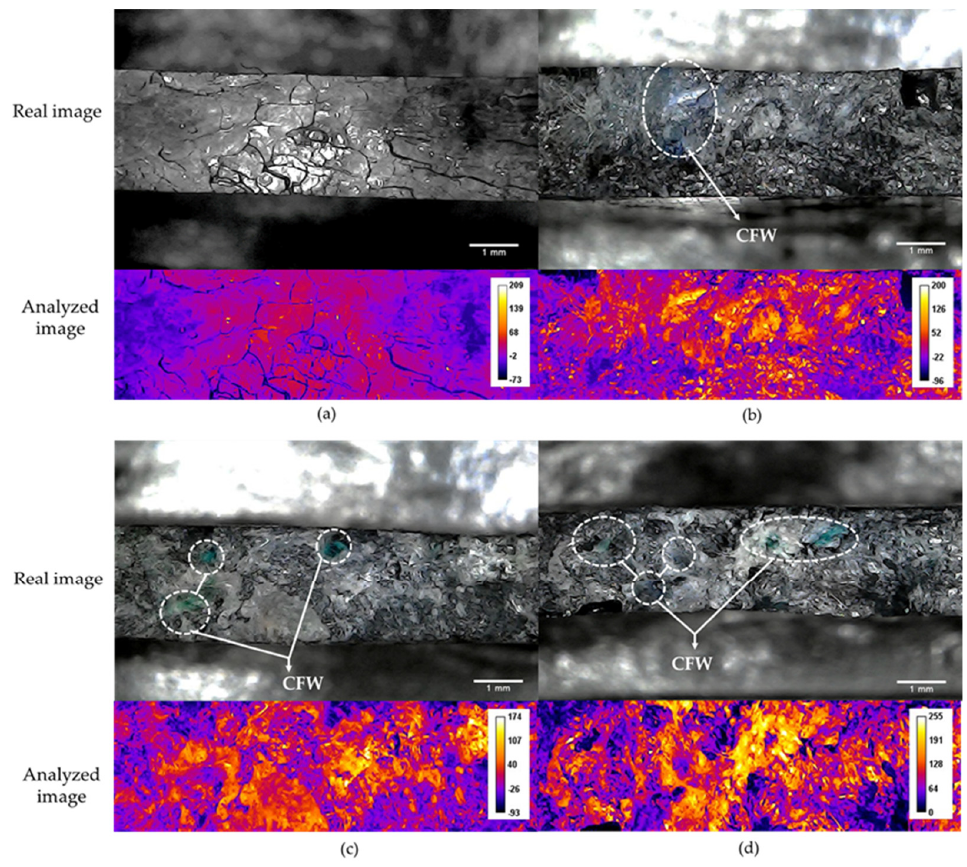
Figure 6. Fiber distribution on the fracture surface.